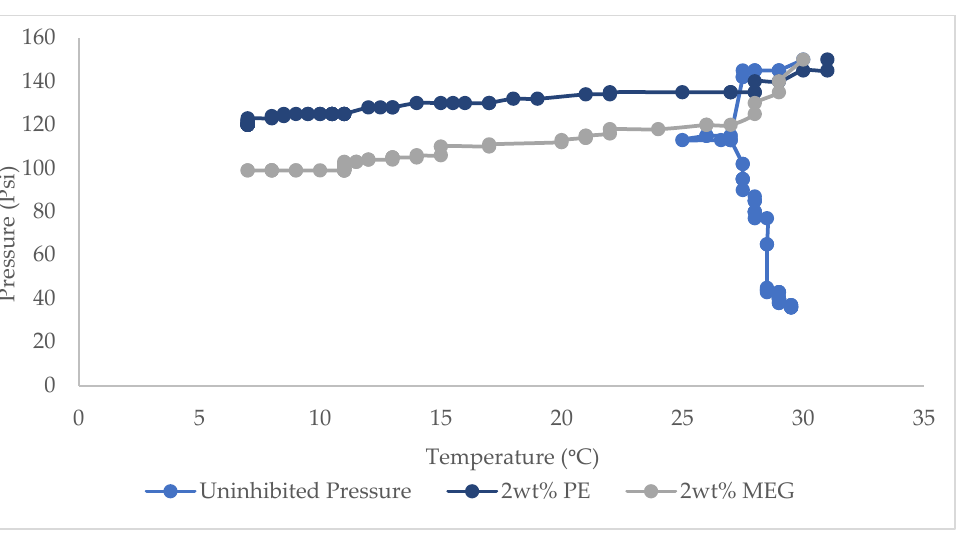
Figure 7. Pressure versus Temperature for 1 wt% Plant Extract (PE), Mono Ethylene Glycol (MEG), and Uninhibited Experiment (water and Gas).